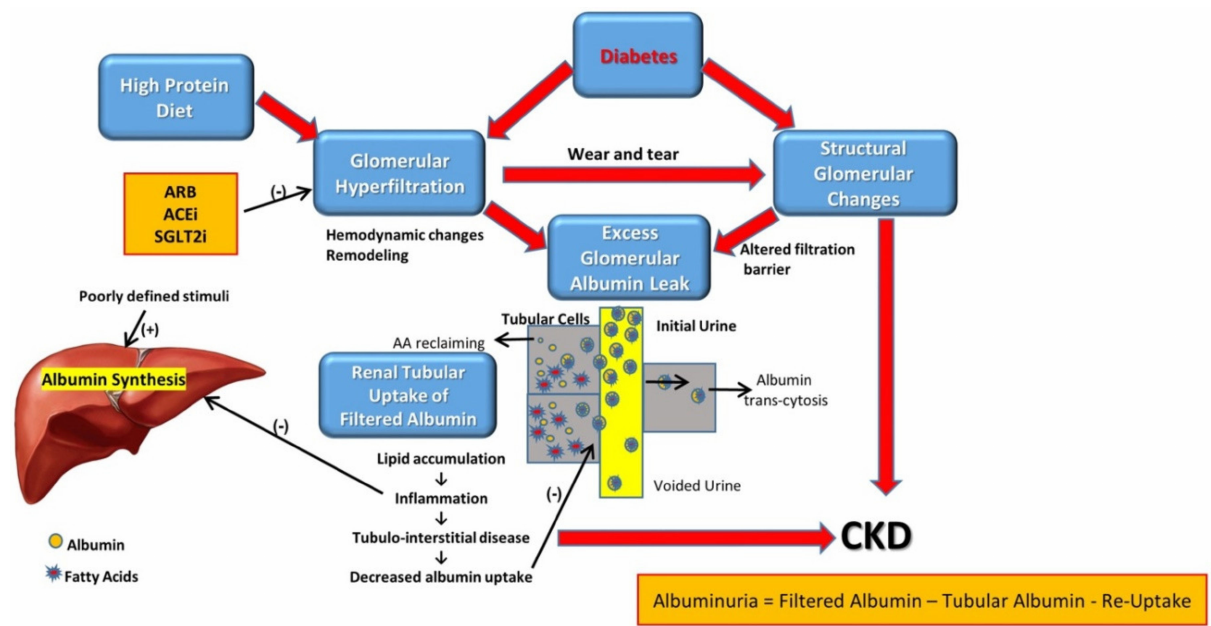
Figure 1. Scheme of albumin fate within the kidney and its association with the pathogenesis of diabetic